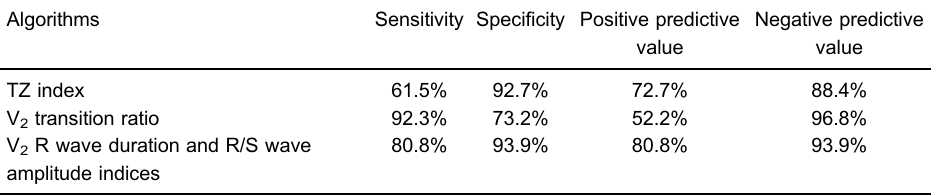
Table 3. Sensitivity, speci fi city, and positive and negative predictive values of the three algorithms. Algorithms